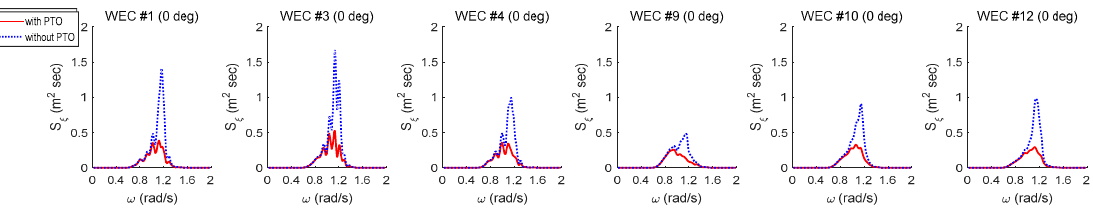
Figure 16. WEC heave motion spectrum for H 1/3 = 1.0 m, T P = 6.67 s, γ = 1.0 in the case of 0.0 deg wave-heading angle.